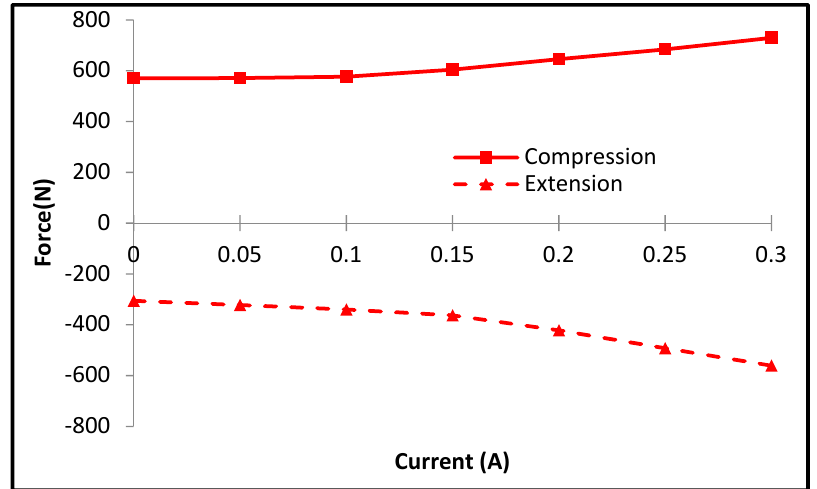
Figure 18. Peak force of MR damper at various currents (measured).